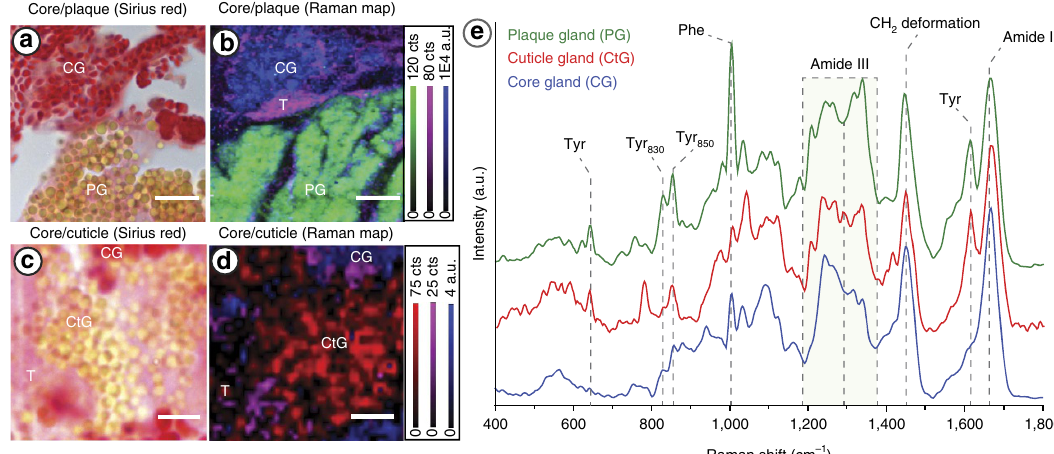
Figure 3 | Raman confocal microspectroscopy of mussel foot glands. ( a ) Sirius red staining and ( b ) composite Raman image of an analogous region of the core/plaque gland interface. The composite Raman confocal spectroscopic image was integrated over three spectral regions, which were found to correspond to the core gland (CG) (Blue; ratio of integration of 1,200–1,292cm (cid:2) 1 to 1,292–1,377cm (cid:2) 1 ), the plaque gland (PG; green; 1,600–1,631cm (cid:2) 1 ) and surrounding tissue (T; violet; 1,550–1,600cm (cid:2) 1 ). ( c ) Sirius red staining and ( d ) composite Raman image of an analogous region of the core/cuticle gland interface The composite Raman confocal spectroscopic image was integrated over three spectral regions corresponding to the cuticle gland (CtG; red; 1,600–1,631cm (cid:2) 1 ), core gland (CG; blue; ratio of integration of 1,200–1,292cm (cid:2) 1 to 1,292–1,377cm (cid:2) 1 ) and surrounding tissue (T; violet; 1,550–1,600cm (cid:2) 1 ). Scale bar is 8 m m for panels a and b , and 3 m m for c and d . ( e ) Average spectra from each of the secretory glands showing a distinctive spectral fingerprint and thus, different protein